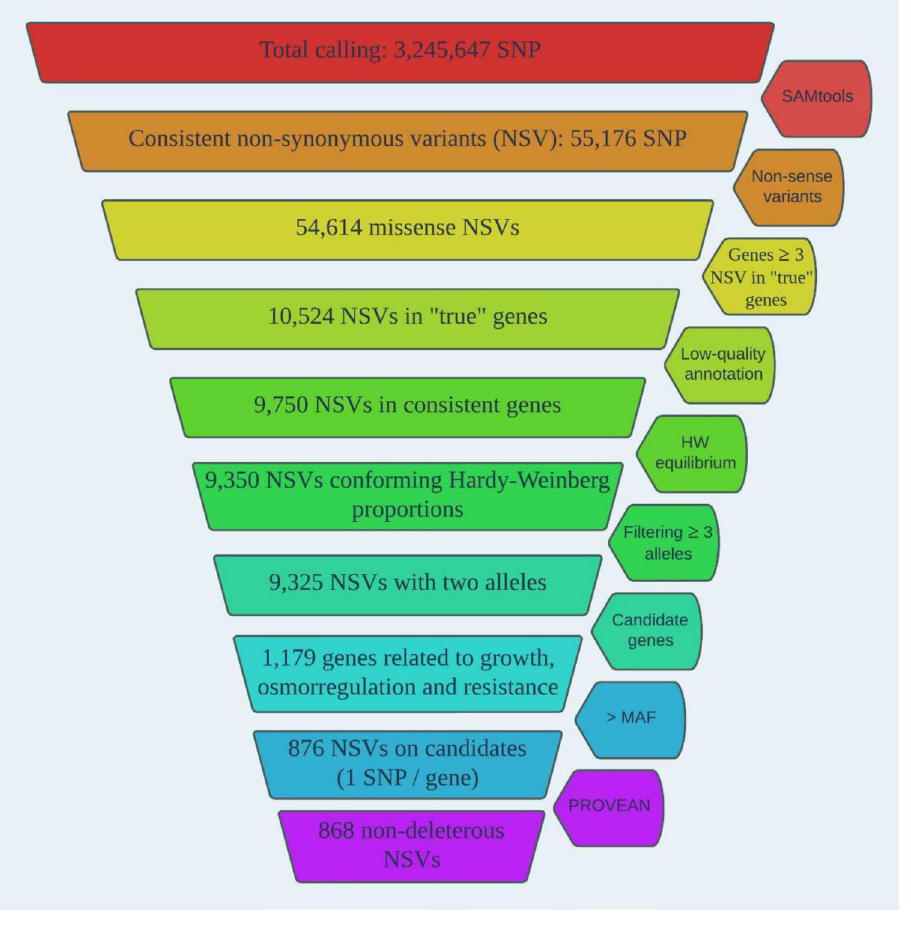
Figure 2. Filtering steps of non-synonymous variants identified in turbot using technical, population genetics and functional